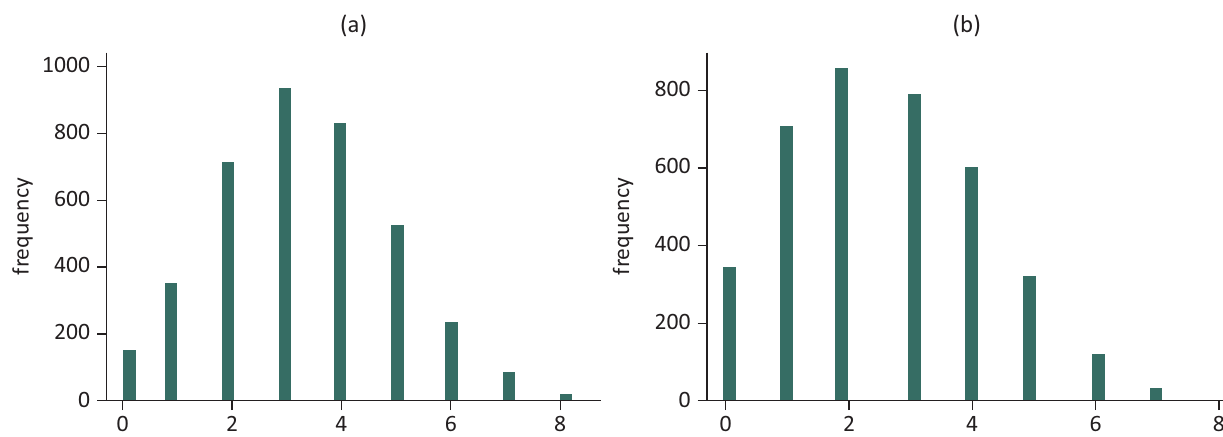
Figure 1. Distribution of respondents within the chooser (a) and moderniser (b) typology index. Source: SOEP (2019), own